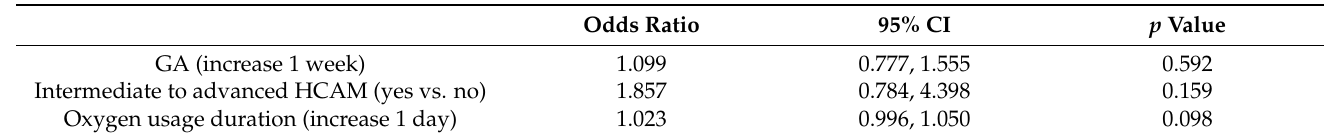
Table 3. Multivariate analysis of the risk factors associated with lenticulostriate vasculopathy in very-low-birth-weight preterm neonates ( n = 130).